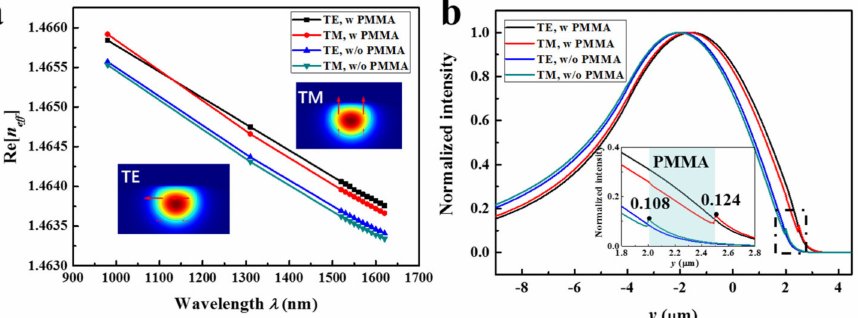
Figure 5. The Full-Vector Finite Element Method (FVFEM) simulation of guiding light between SPF and PMMA. ( a ) The real part of the effective refractive index changing with the wavelength of the TE and TM modes with/without PMMA film. The graphene and Au films are absent in the calculation. Insets show the TE and TM mode distributions in the cross plane for 1550 nm with PMMA. ( b ) Normalized intensities of the TE and TM modes along the y-axis for the cases with and without PMMA. Inset zooms in the region with PMMA